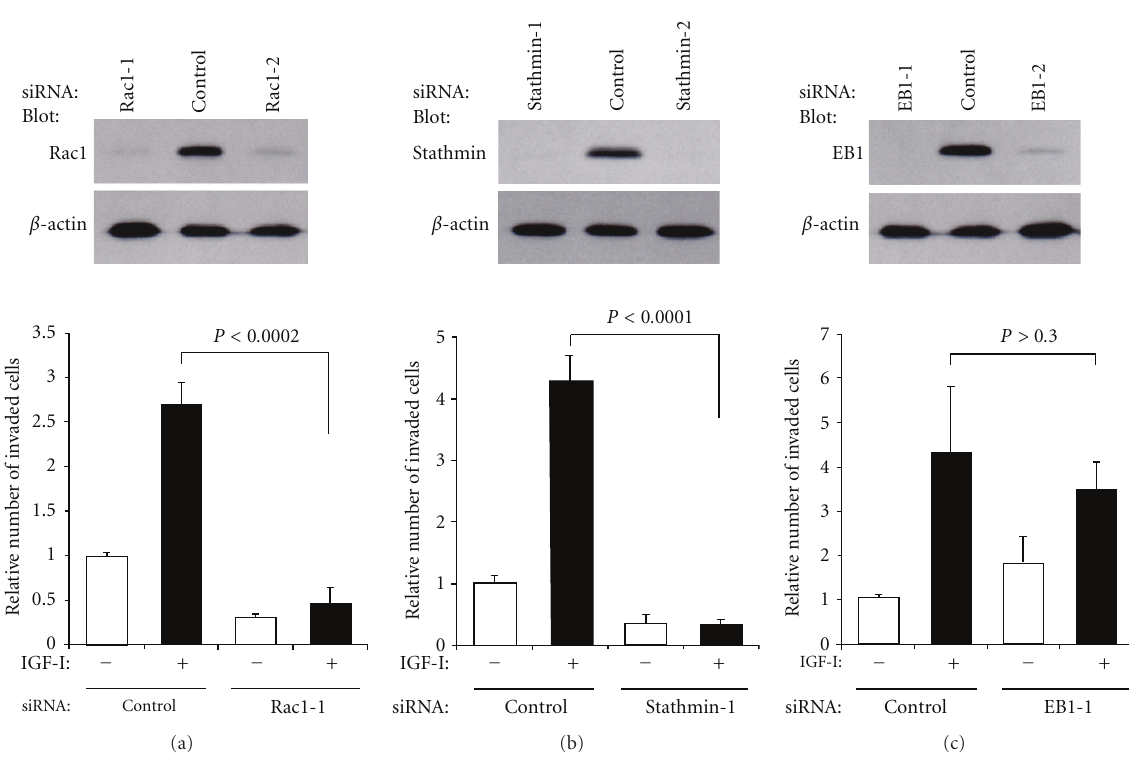
Figure 6: Rac1 and stathmin but not EB1 are required for IGF-I-induced invasion of MDA-MB-231 cells. Cells after incubation for 48 h with mismatch negative control small interfering RNA and 2 di ff erent small interfering RNAs of Rac1 (a), stathmin (b), or EB1 (c) were lysed and the same amounts of total cell lysates were immunoblotted with antibodies to β -actin and Rac1 (a), stathmin (b), or EB1 (c). Cells transfected with control small interfering RNA and Rac1-1 (a), stathmin-1 (b), or EB1-1 small interfering RNA (c) were incubated for 6h toward medium containing (+) or lacking ( − ) IGF-I. The mean (SD) values of triplicate assays are given as the number of invaded cells relative to that in unstimulated control MDA-MB-231